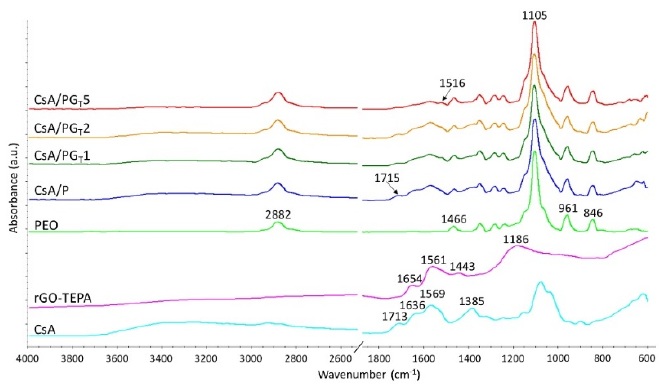
Figure 4. ATR-FTIR spectra of raw materials (PEO, rGO-TEPA, CsA), CsA/P, CsA/PG T 1, CsA/PG T 2, and CsA/PG T 5 nanofibrous membranes.